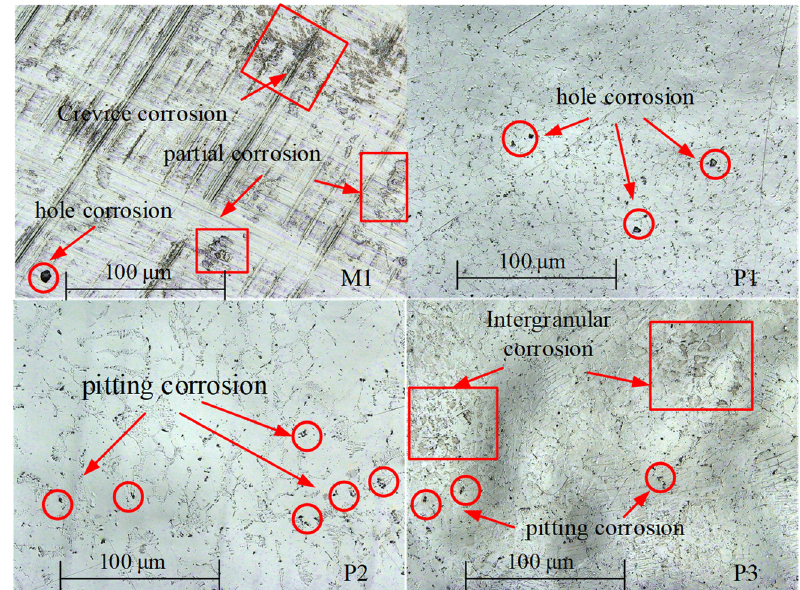
Figure 14. Corrosion morphology of milling and electrochemical polishing samples.